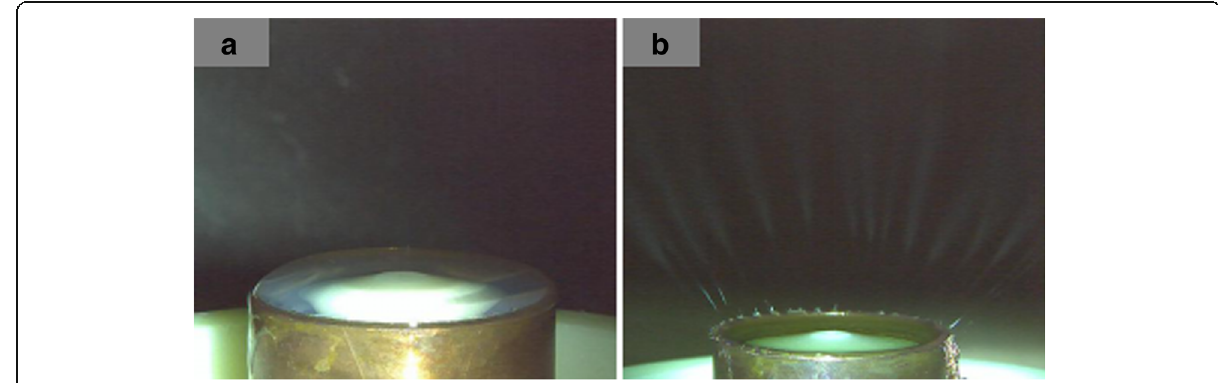
Fig. 2 Photograph of the MFSE without SDBS. a Photograph of liquid surface and b photograph of spinning process